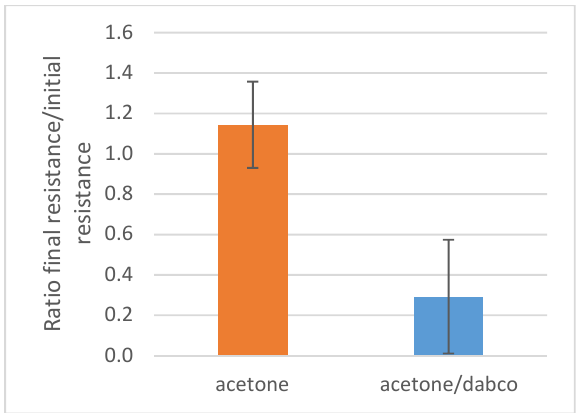
Figure 10. Composites dried on electrodes were submerged in acetone or in a DABCO solution in acetone (0.45 mol/L). After taking them out and waiting 24 h, the electrical resistance was compared with the original resistance from which a ratio was calculated. The average of four measurements was reported.